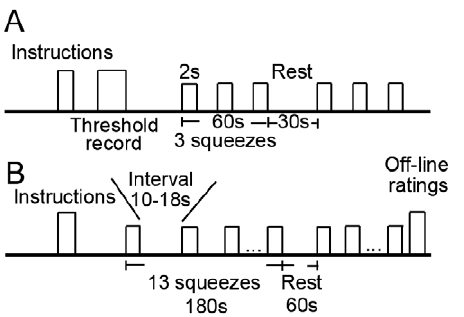
Figure 6. Procedural timeline for behavioral tests and fMRI scanning. (A) Subjects underwent self-induced and externally induced squeezes in the pressure and pain conditions in a within-subjects design. Squeeze for 2 seconds/trial was repeated three times in 60 seconds. The interval between conditions was 30 seconds. All conditions were repeated three times, and condition order was randomly determined and counterbalanced. (B) During fMRI scanning, squeeze was repeated thirteen times in each condition with 10– 18 seconds between trials. Each condition lasted for 180 seconds, and the interval between conditions was 60 seconds. Subjects gave off-line VAS ratings after scanning was completed.